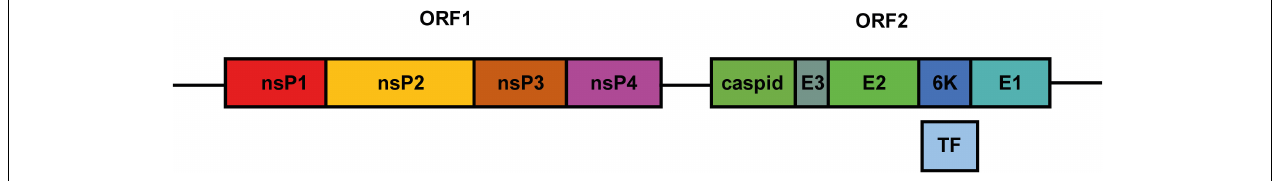
FIGURE 1 | Schematic diagram of the CHIKV genome. The genome of CHIKV is a single-strand RNA compromising two ORFs. ORF1 encodes four nsPs. Translation and further processing of ORF2 produce structural proteins capsid, E3, E2, 6K, and E1. During translation, ribosome shifts to –1 reading frame in 6K, leading to the production of TF